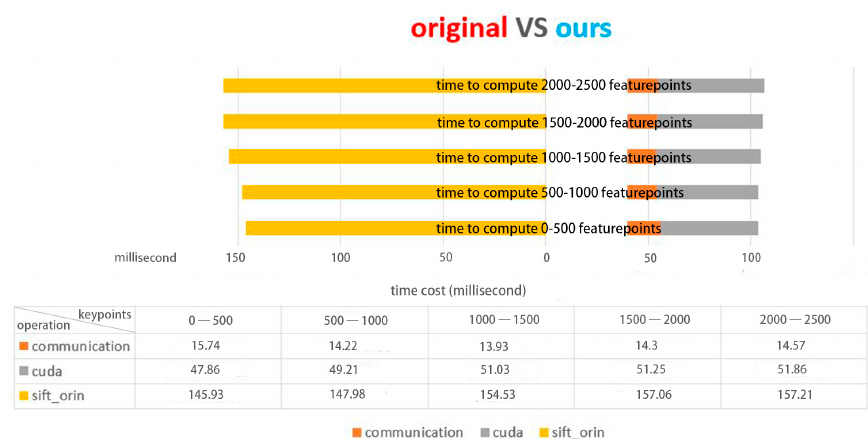
Figure 8. Time consumption on feature extraction.